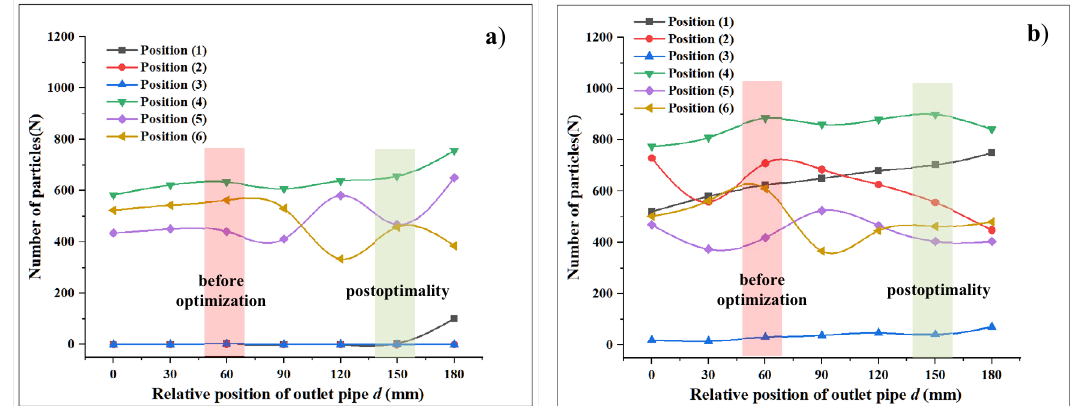
Figure 17. Number of particles passing through the position at different particle generation rates: ( a ) steel shots; ( b ) waste